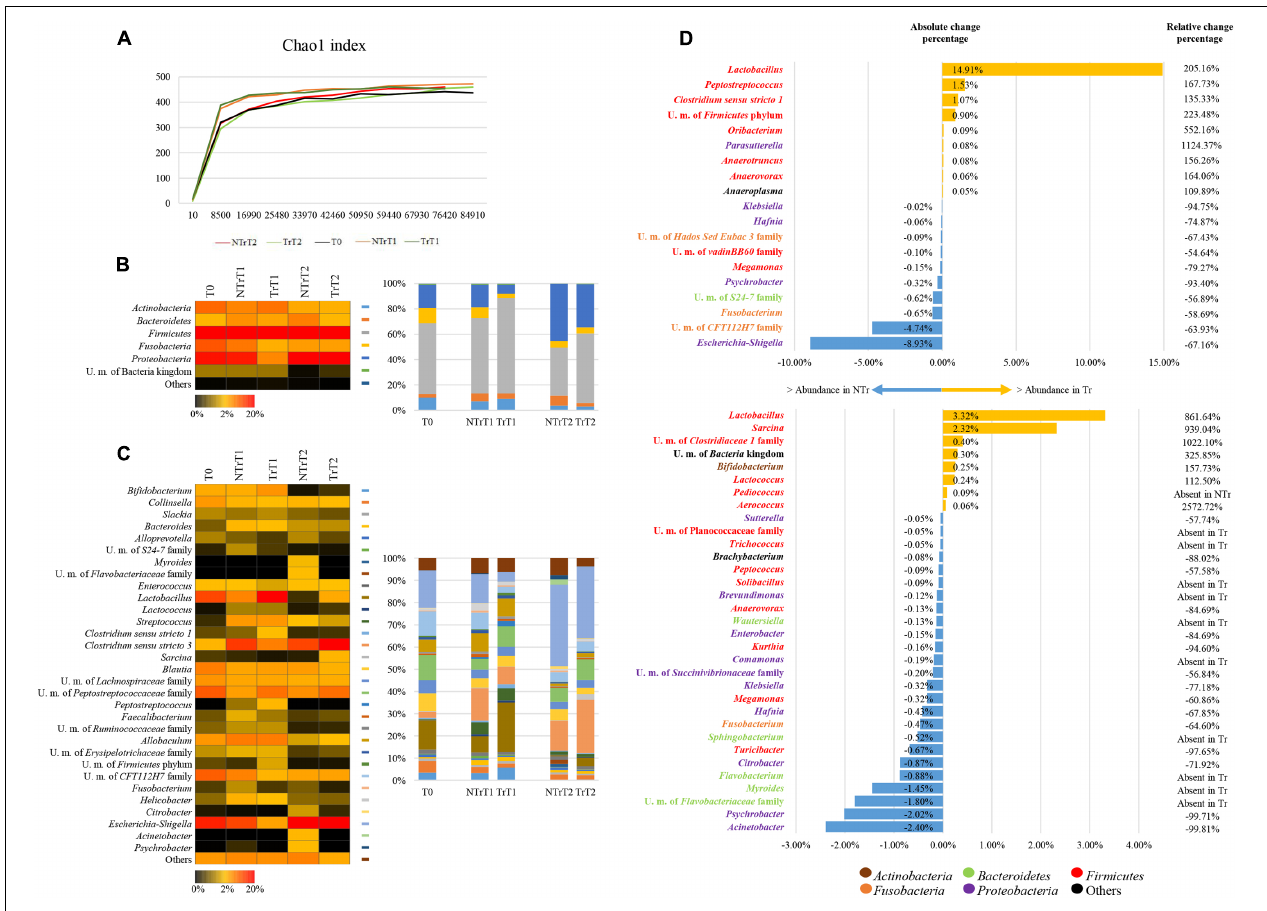
FIGURE 1 | Exploration of the taxonomic profile of NTr and Tr groups. (A) Shows the rarefaction curves representing variation of the Chao1 and the Shannon diversity indexes at increasing sequencing depth of NTr and Tr fecal samples. (B) Displays bar plots and heat map of the identified bacterial phyla in the pooled CZ treated or untreated samples. (C) Represents bar plots and heat map of the identified bacterial genera in the pooled Tr or NTr samples. (D) exhibits the variation of taxa at time point T1 (upward) and T2 (below). We reported the bacterial genera with absolute change percentage > 0.05% and showing increase > 100% or decrease < − 50% of relative change percentage in Tr data sets as compared to those obtained from NTr samples. In all panels the term unclassified member is abbreviated to U. m.. TABLE 2 | Effects of chabazitic zeolitite (CZ) supplementation on fecal score and fecal microbial concentration (least squares means of log 10 CFU g − 1 of feces).